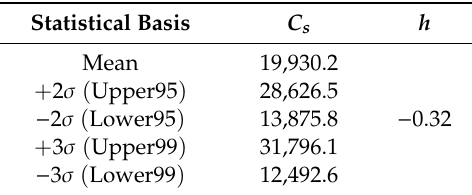
Table 1. Master S-N curve